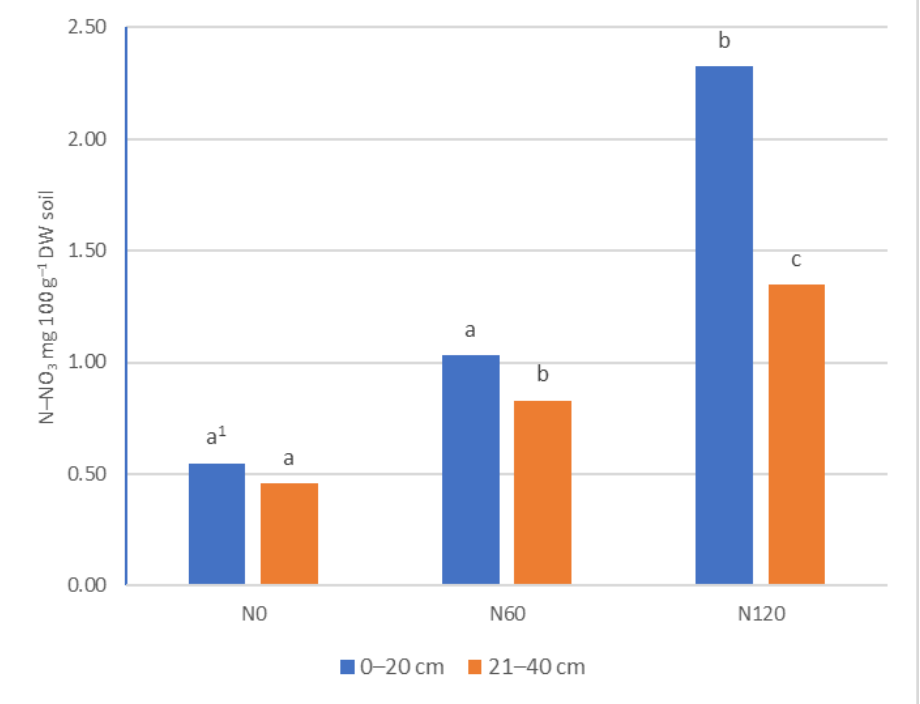
Figure 2. The content of N-NO 3 depending on nitrogen fertilization in the soil layer 0–20 cm and- 21–40 cm. Statistical analysis performed separately for each soil level. 1 means that the same letters for each soil level are not significantly different at α = 0.05 (Duncan’s test).